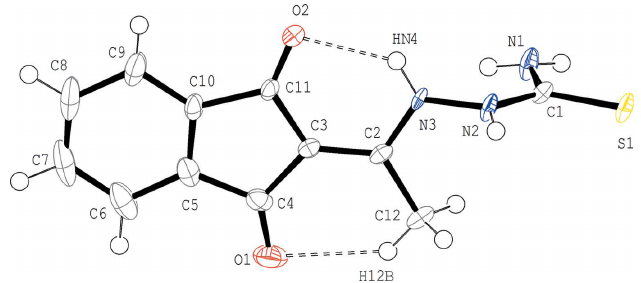
Figure 1 The molecular structure of the title compound, showing the atom- labelling scheme. Displacement ellipsoids are drawn at 50% probability level. Intramolecular N—H (cid:3)(cid:3)(cid:3) O and C—H (cid:3)(cid:3)(cid:3) O hydrogen bonds are shown as dashed lines.